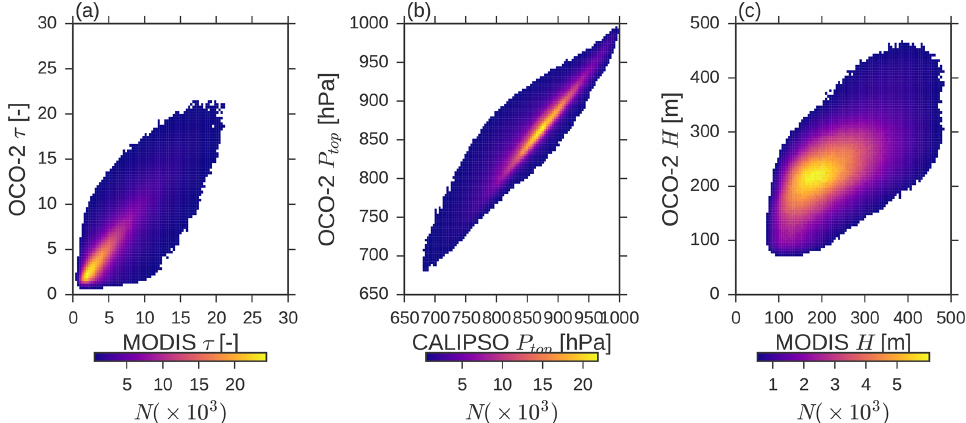
Figure 6. 2-D histograms of (a) MODIS versus OCO-2 cloud τ , (b) CALIPSO versus OCO-2 P top and (c) MODIS versus OCO-2 H , with MODIS H being equivalent thickness based on retrieved liquid water path combined with Eq. (4) and f ad = 1. Bins with N< 500 are masked, and only OCO2CLD-LIDAR-AUX Quality_flag = 0 retrievals are shown.